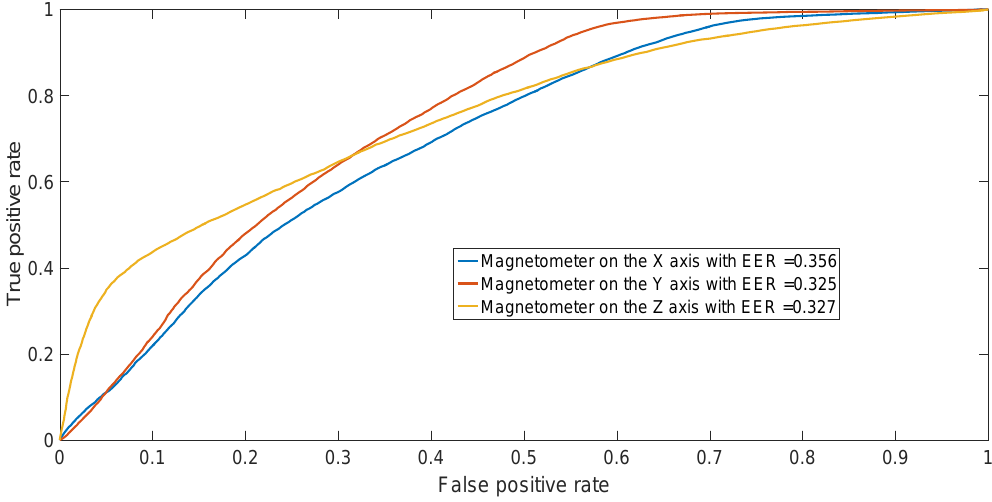
Magnetometer on the X axis with EER =0.356 Magnetometer on the Y axis with EER =0.325 Magnetometer on the Z axis with EER =0.327